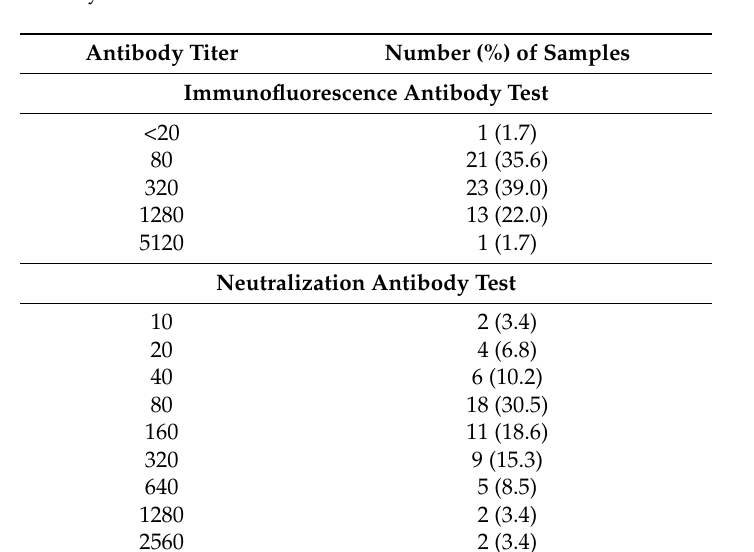
Figure 3. Comparison of neutralization antibody titer and immunofluorescence antibody titer of dromedary serum samples for dromedary camel coronavirus UAE-HKU23. Numbers of serum samples with that particular neutralization antibody and immunofluorescence antibody titers are indicated by points with different colors. Table 1. Dromedary camel coronavirus UAE-HKU23 antibody detection by immunofluorescence and neutralization antibody tests.